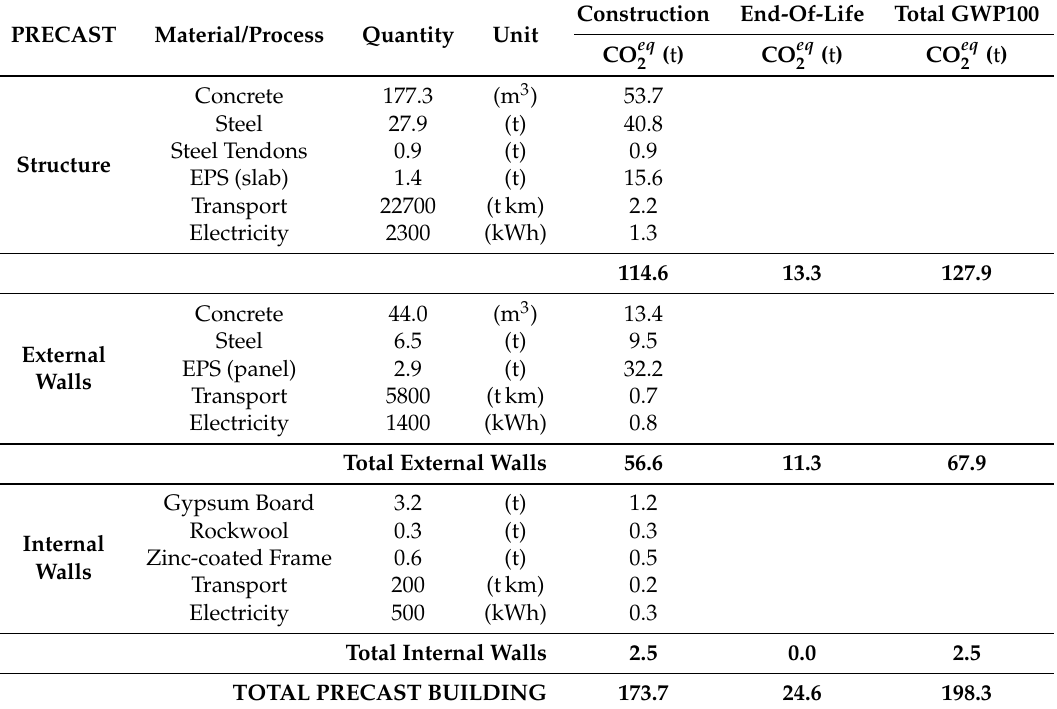
Table 3. Carbon footprint of the precast building (excluding use phase).